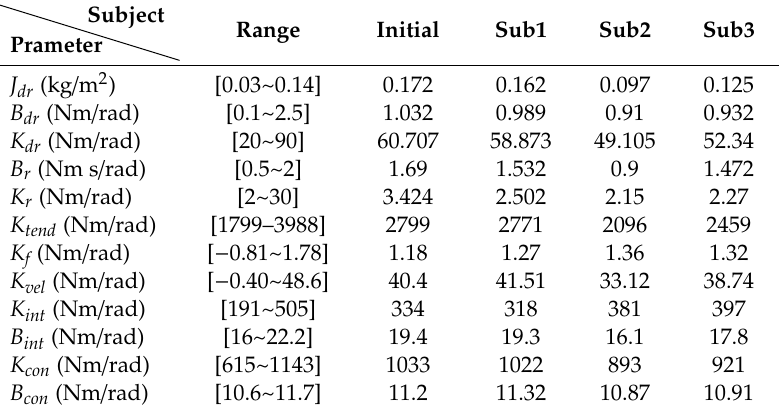
Table 4. Identified parameter of NMS characteristics.